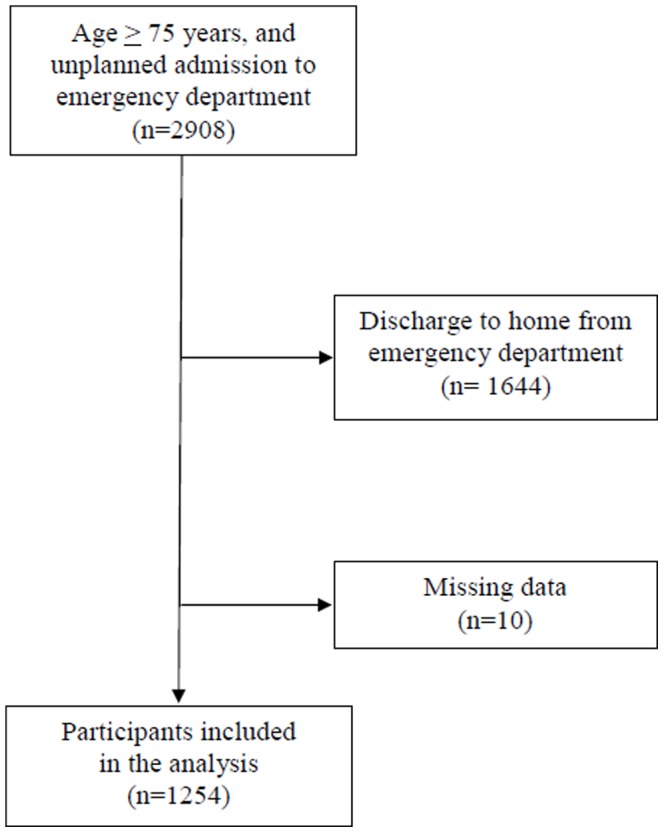
Flow chart showing the selection of participants included in the analysis.